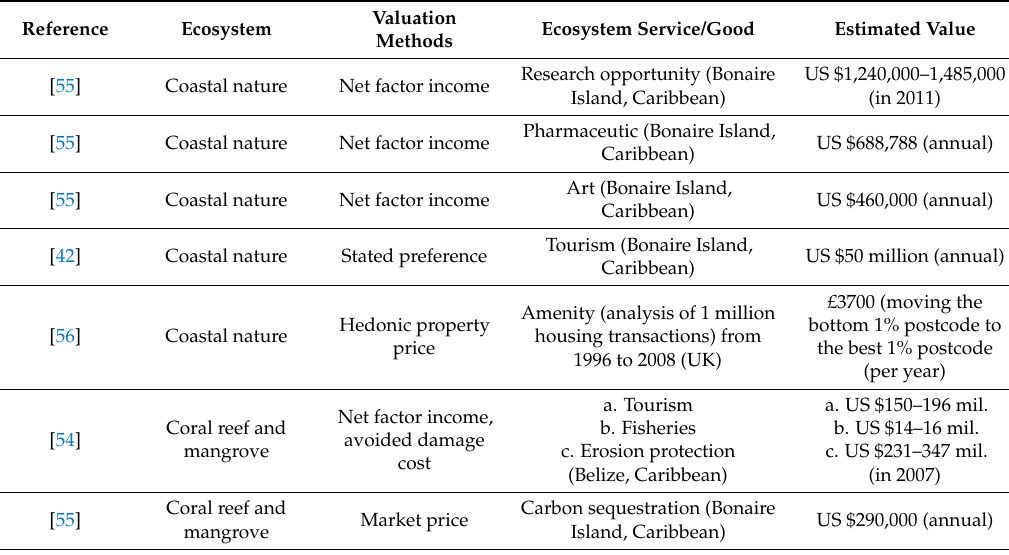
Table 7. Selected applications of valuation of combined coastal